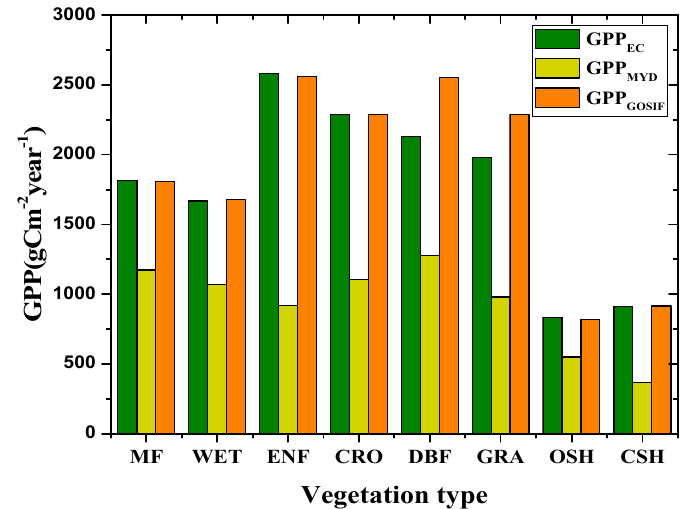
Figure 3. Annual average GPP of different vegetation types from 2015 to 2017. The vegetation type is represented by the x-coordinate, and the annual average GPP is represented by the y-coordinate. Green represents GPP EC , yellow represents GPP MYD , and orange represents GPP GOSIF .